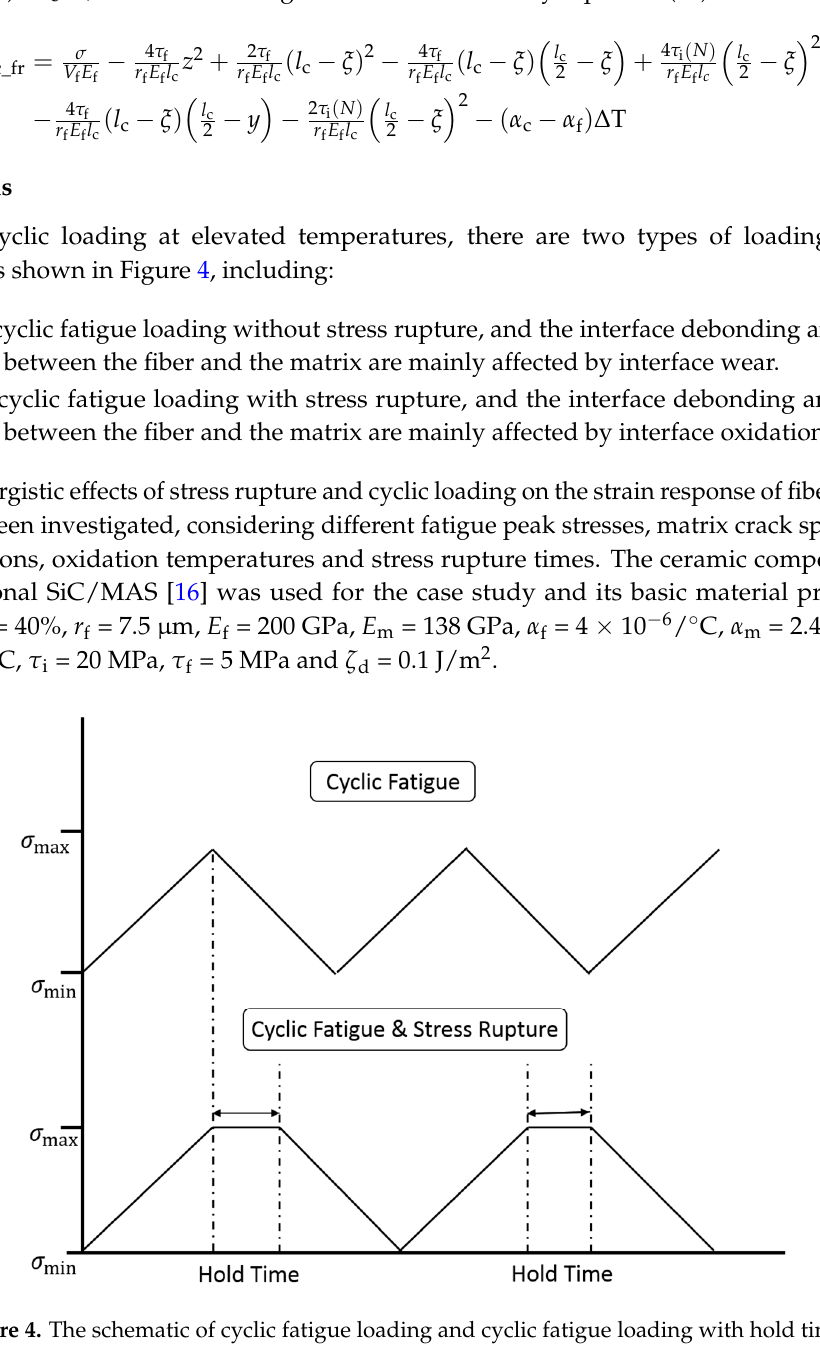
Figure 5. The interface shear stress degradation model. 5.1. Effect of Stress Rupture Time The peak strain ε max , the interface debonded length 2 l d / l c , and the interface oxidation length ξ / l d versus the cycle number curves under σ max = 200 MPa, corresponding to different stress rupture times of t = 1, 5 and 10 s at the oxidation temperature of Tem = 800 °C, are illustrated in Figure 6.